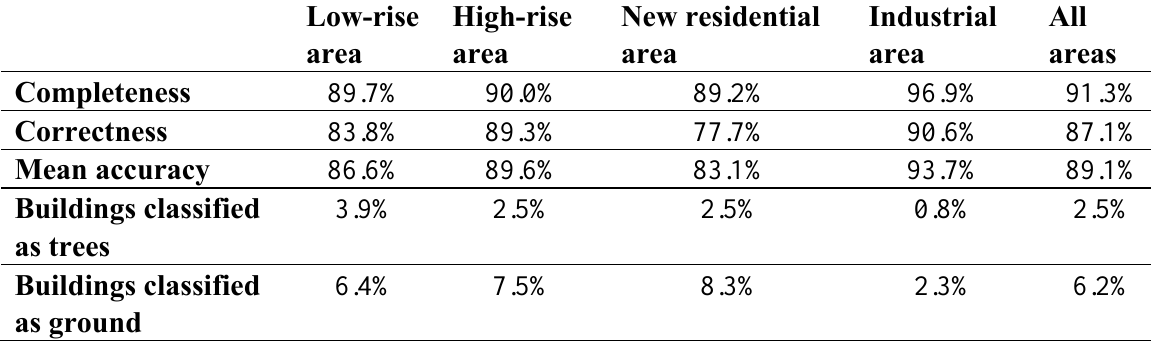
Table 2. Pixel-based accuracy estimates for the building detection